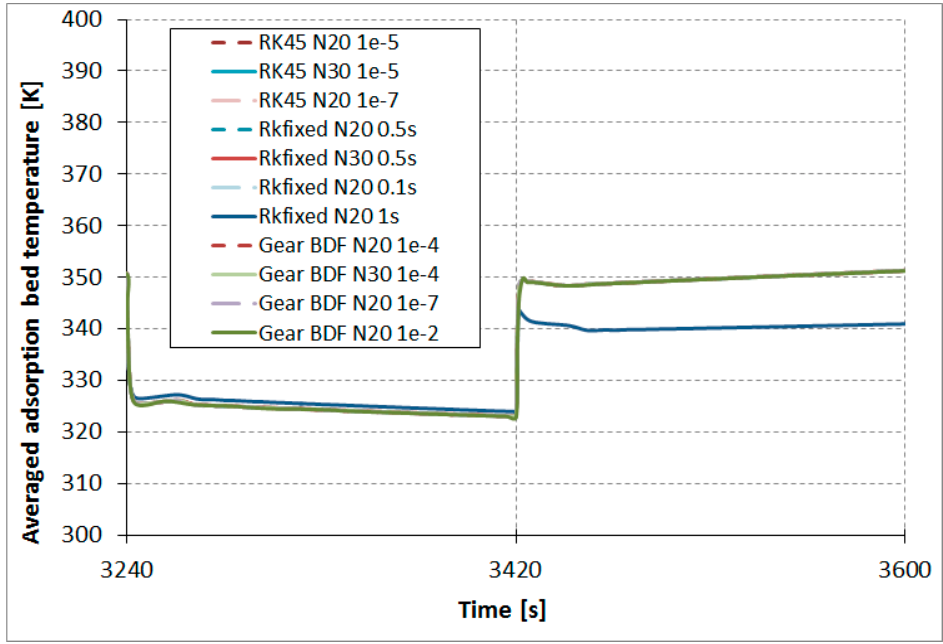
Figure 8. Results comparison of the RKfixed, RK45, and Gear BDF methods in different accuracies and discretizations, calculated averaged adsorption bed temperatures T a .